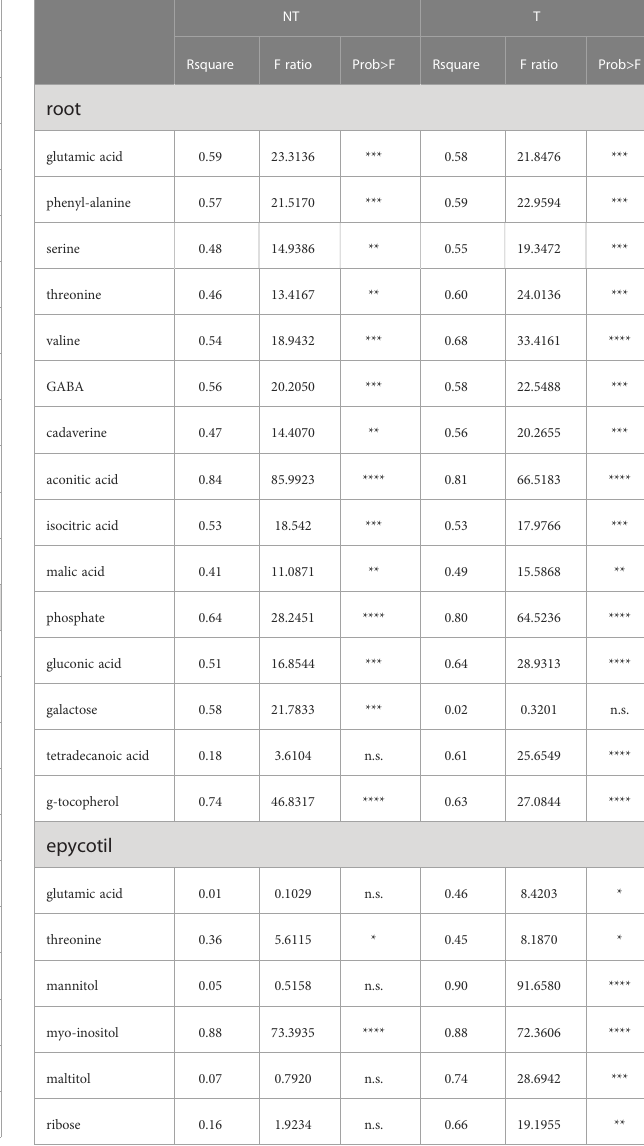
con fi rming the important role of mannitol in plant growth. In lentil, among the fatty acids, hexadecanoic acid and tetradecanoic acid were signi fi cantly in fl uenced by MWT, but only tetradecanoic acid was positively correlated with root elongation. This con fi rms the role of saturated fatty acid in the biosynthesis and/or regulation of TABLE 5 Correlation between morphological traits (root and epicotyl lengths) and metabolites ’ content for non-treatment (NT) and treatment (T) conditions in lentil. NT